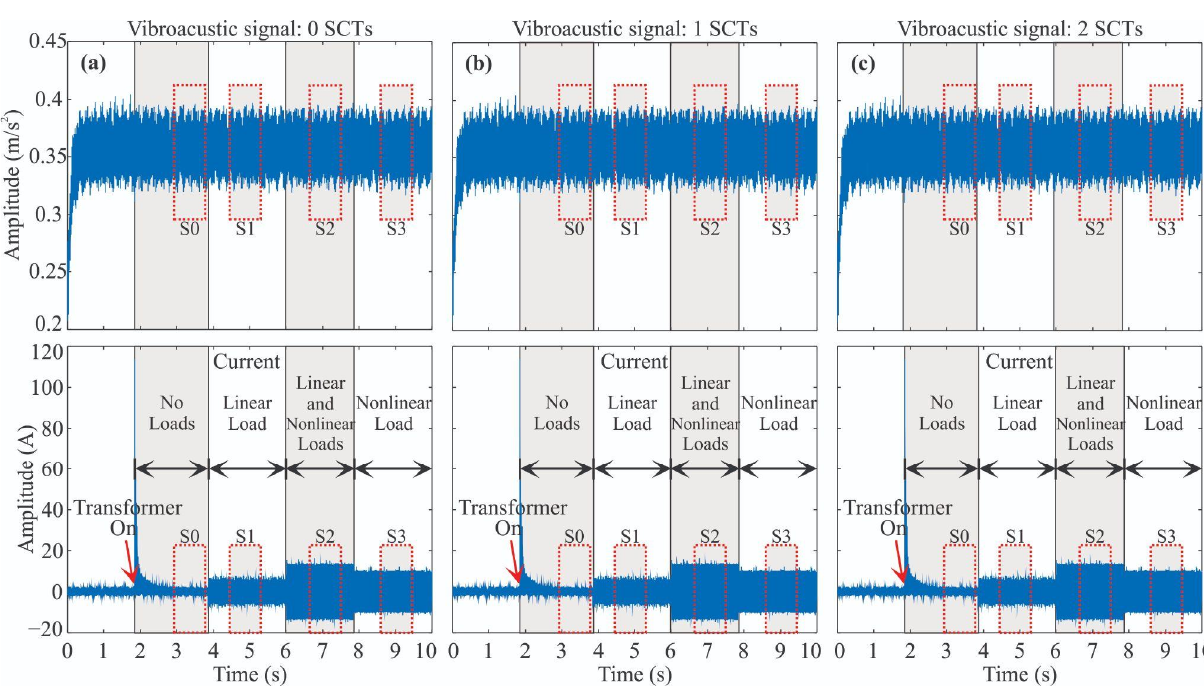
Figure 4. Signals acquired from the transformer: VA signals for: ( a ) 0 SCTs, ( b ) 1 SCTs, and ( c ) 2